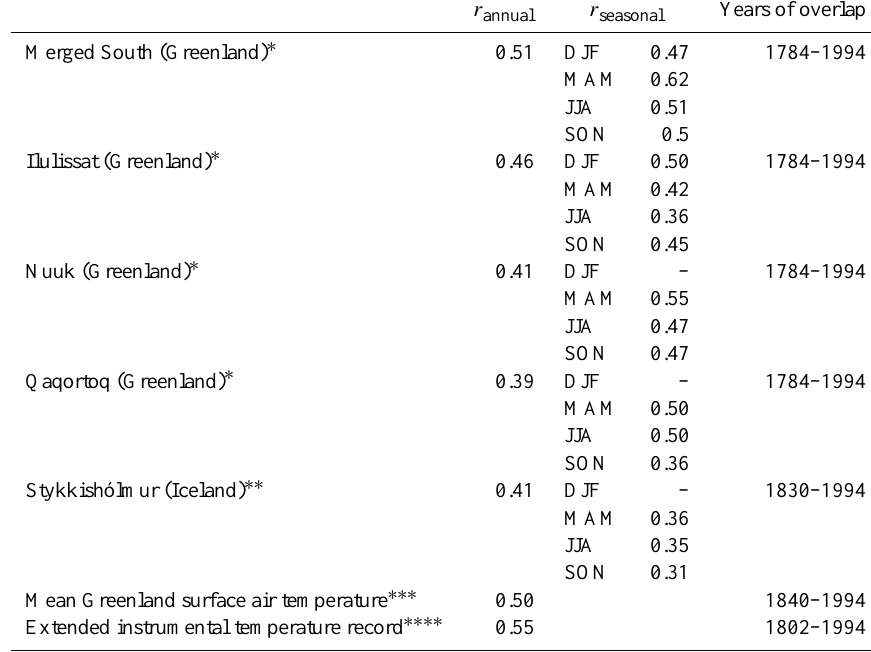
Table 5. Correlation coefficients ( r ) of the stacked δ 18 O record with annual and seasonal (DJF, MAM, JJA and SON) extended Greenland temperature records ∗ (Vinther et al., 2006a), northwestern Iceland instrumental data ∗∗ (Hanna et al., 2004; Jónsson, 1989), annual mean Greenland ice sheet near-surface air temperatures from combined instrumental and model output ∗∗∗ (Box et al., 2009) and Arctic temperature reconstruction ∗∗∗∗ (Wood et al., 2010). All correlations are done with 5-year running means and are significant at the 95% level ( p